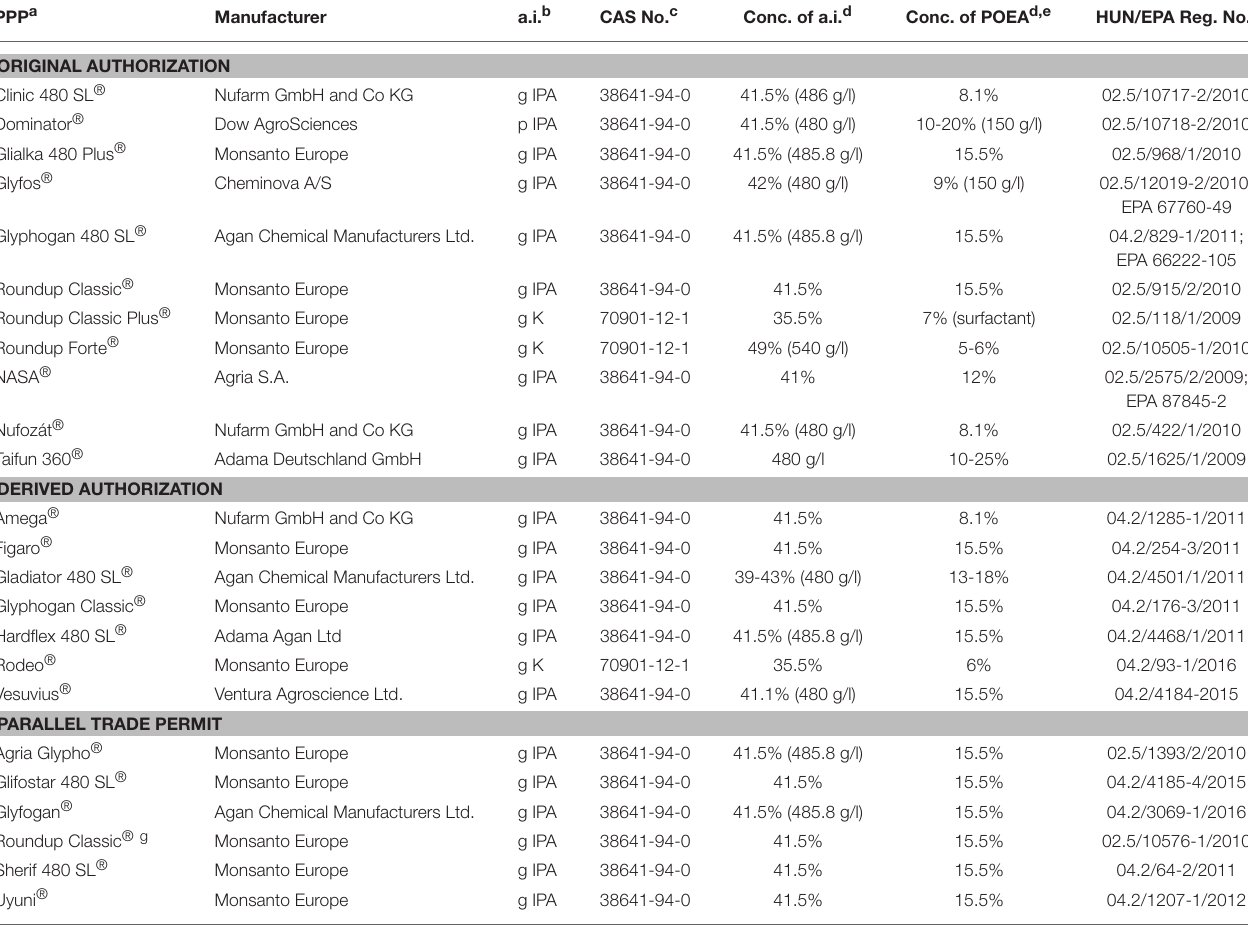
TABLE 2 | Glyphosate-based herbicide formulations banned n Hungary, as of November 30, 2016, due to their content of polyethoxylated tallowamine